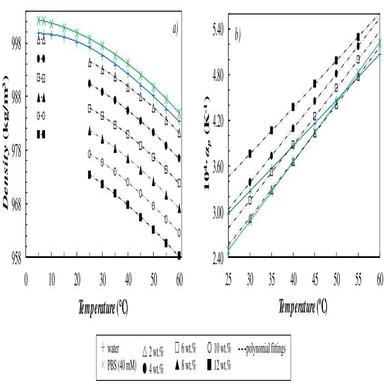
(a) Density and (b) isobaric thermal expansivity, αp, as a function of temperature for water, the phosphate buffer solution (PBS) and the optimized C18Me:C16: C14Me− in− water nanoemulsions prepared with different percentages of dispersed phase (2–12 wt%).